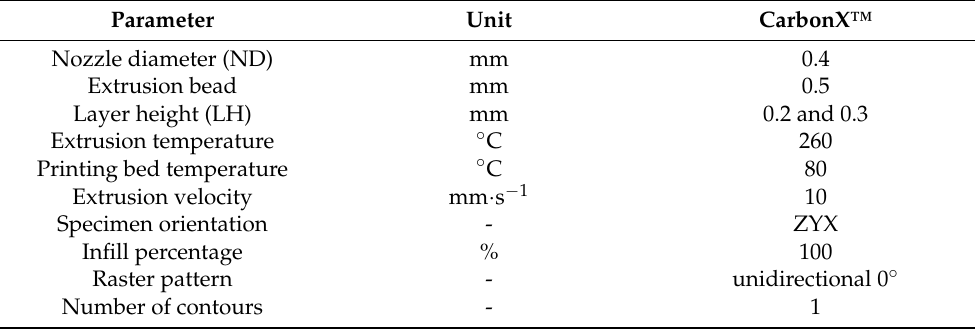
Figure 2. Manufacturing orientation and scheme for as built surface texture. Table 1. Selected manufacturing parameters for material extrusion process in Simplify 3D.